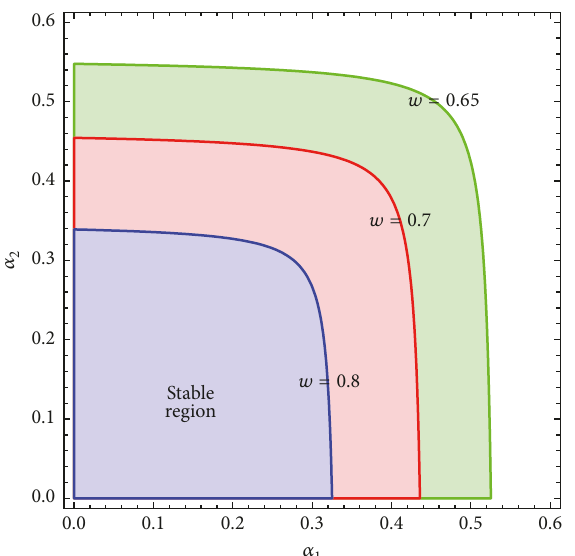
Figure 11: The stable region of adjustment speeds when 𝜃 = 0.6 , 𝛼 = 0 , and 𝑤 = 𝑤 . 𝑖